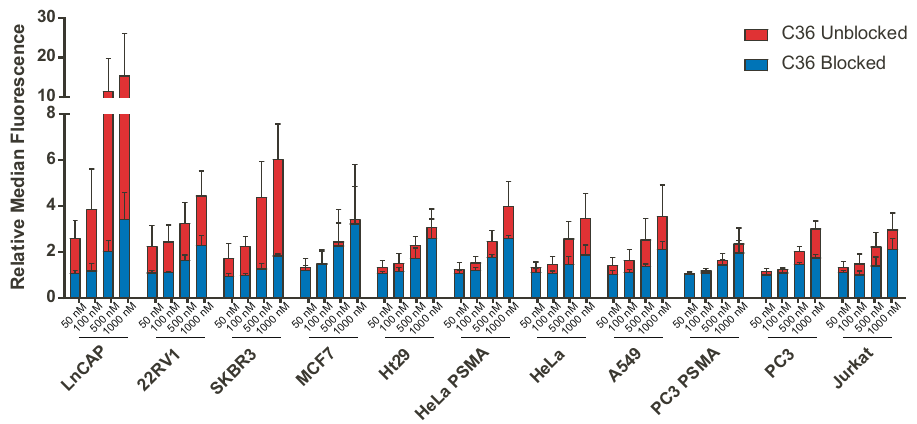
Fig. 2 Variation of non-speci fi c binding/uptake across cell types. The indicated cell line was incubated at 37 °C with 50 nM, 100 nM, 500 nM, and 1000 nM of a DY650 labeled non-binding control aptamer, C36, with or without 1 mg/mL ssDNA in full growth media for 1 h. The fold change in median fl uorescence relative to unstained cells are shown. Samples with ssDNA blocking added (blue) are superimposed on data derived from the same experiment performed in the absence of ssDNA (red). Data represent three independent experimental replicates. Source data are provided as a